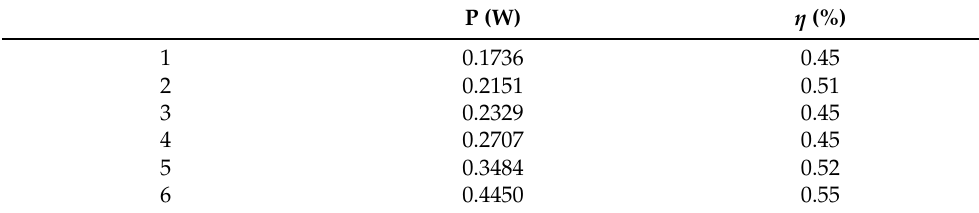
Table 4. Value of power generated by each module and actual